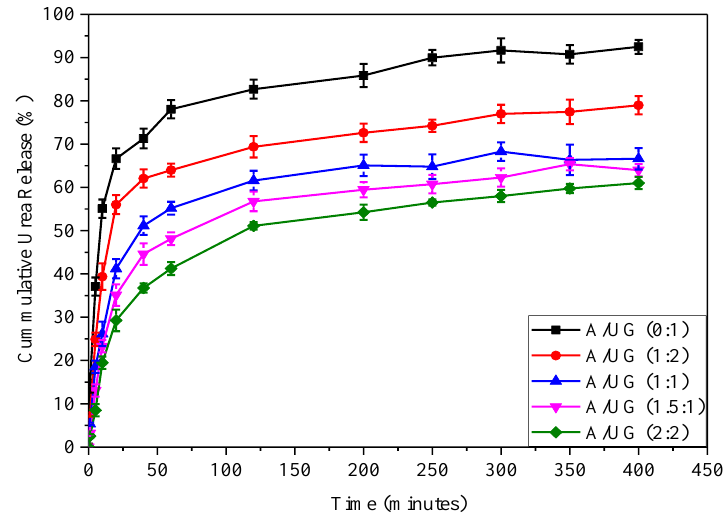
Figure 8. The impact of adding wood ash on the A/UG film’s urea release pattern (2:1). All values in the figure are represented as mean ± standard deviation.